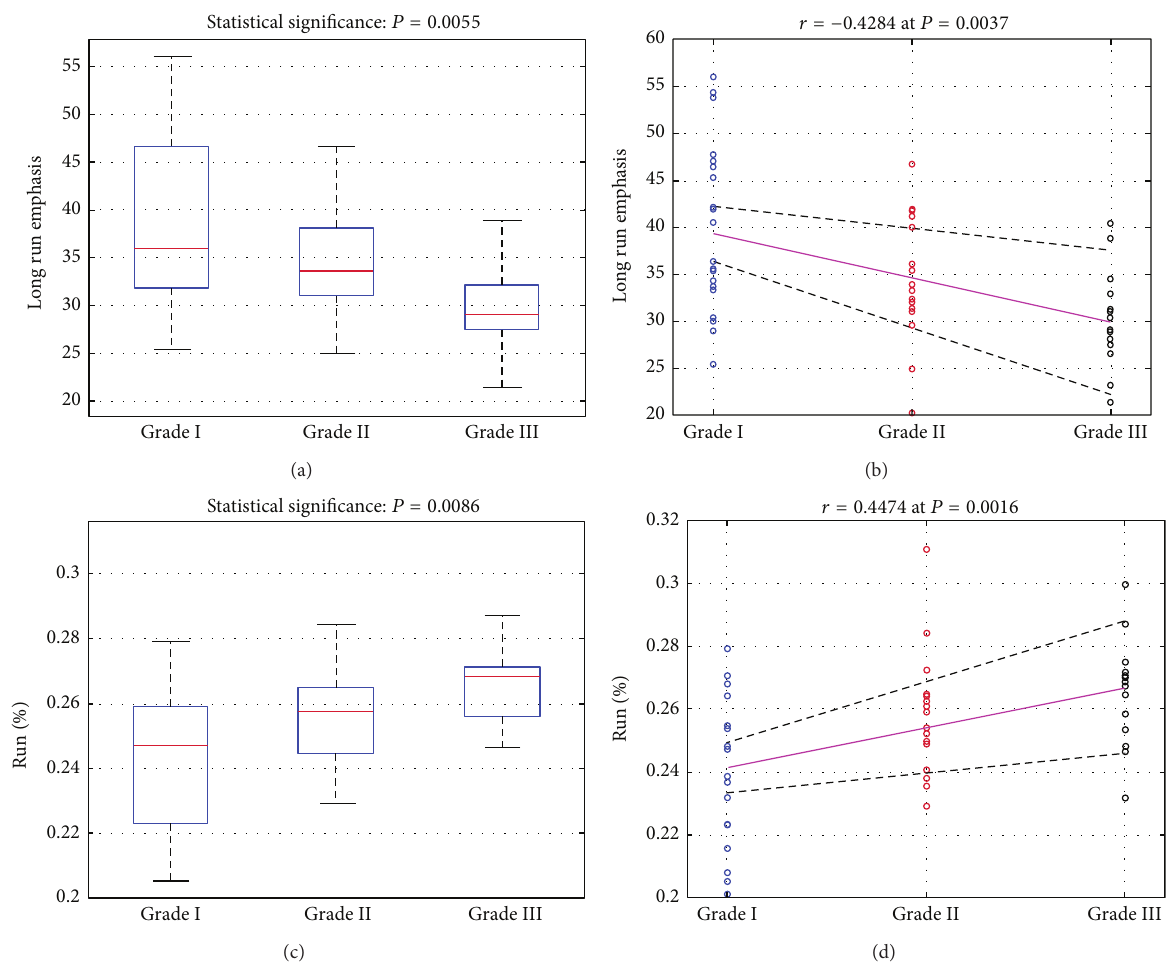
Figure 2: Box plots and correlation plots of the Long Run Emphasis ((a) and (b)) and Run Percentage ((c) and (d)) features, respectively, sustaining statistically significant differences ( 𝑃 < 0.01 ) between the three laryngeal grades.